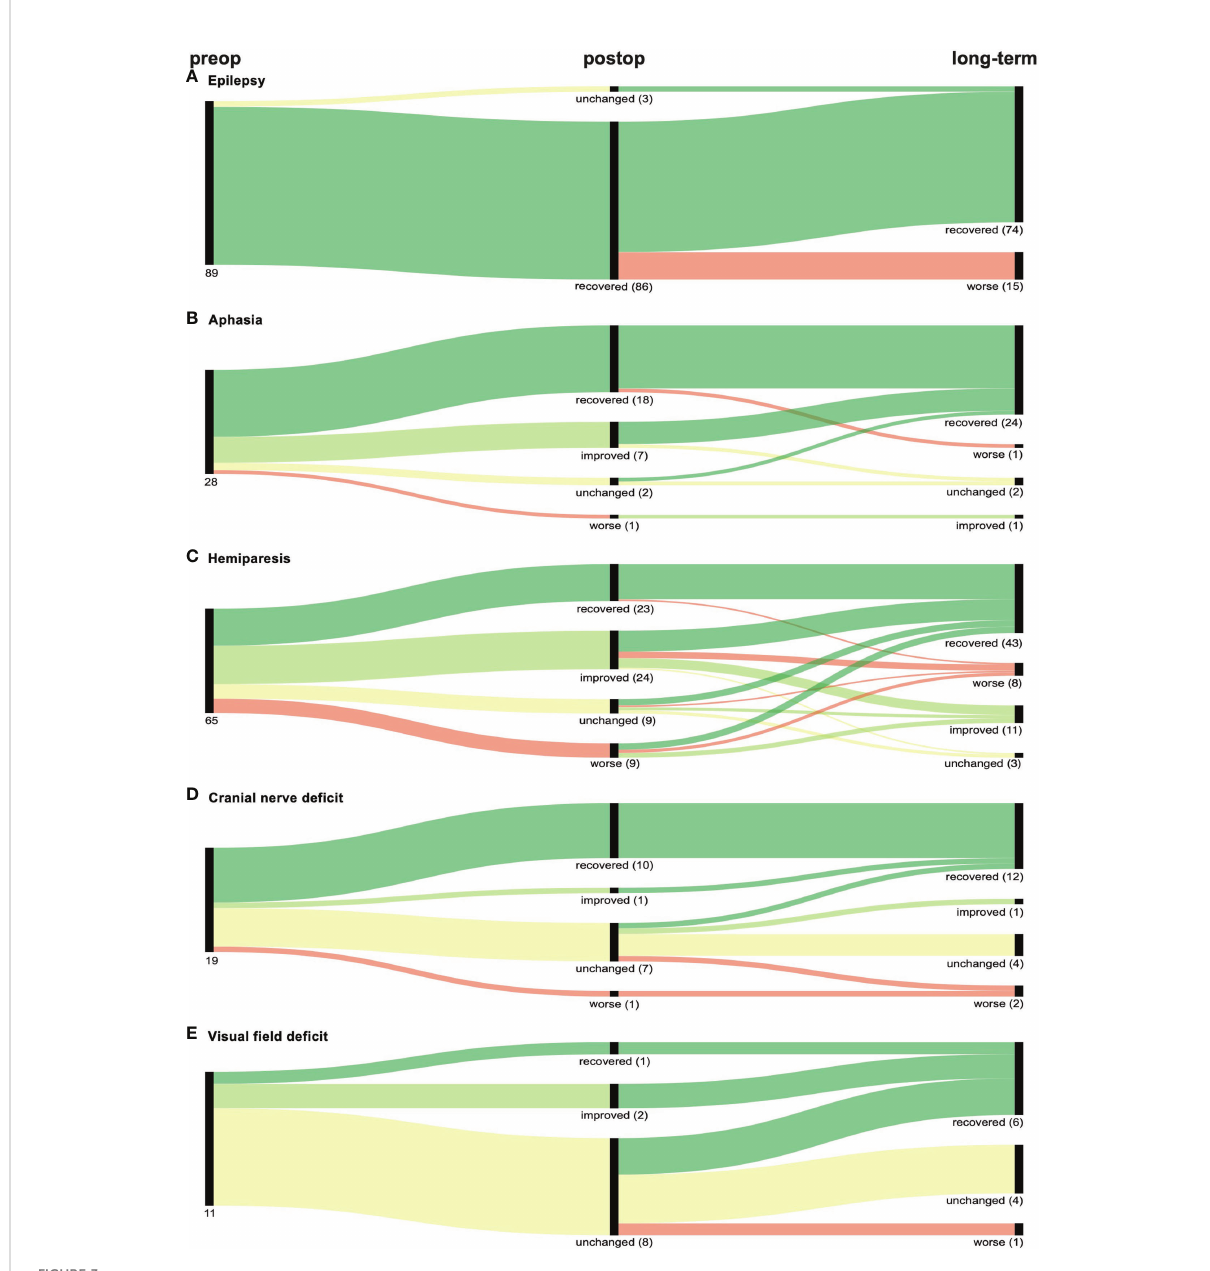
FIGURE 3 Graphical representation (Sankey plots) of the neurological outcome of patients with preoperative (preop) (A) epilepsy, (B) aphasia, (C) hemiparesis, (D) cranial nerve de fi cit or (E) visual fi eld de fi cit within 30 days after surgery (postop) and at last follow-up (long-term). Symptom improvement and recovery is represented in light and dark green respectively while worsening of symptoms is depicted in red. No change in de fi cits is marked yellow. Numbers in parenthesis indicate number of patients of each